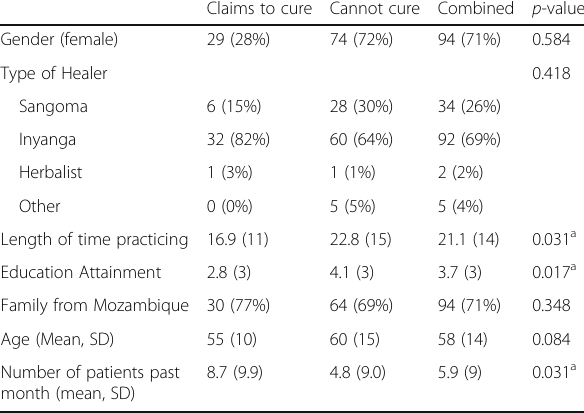
Table 1 Healer characteristics by claim to cure HIV Claims to cure Cannot cure Combined p -value